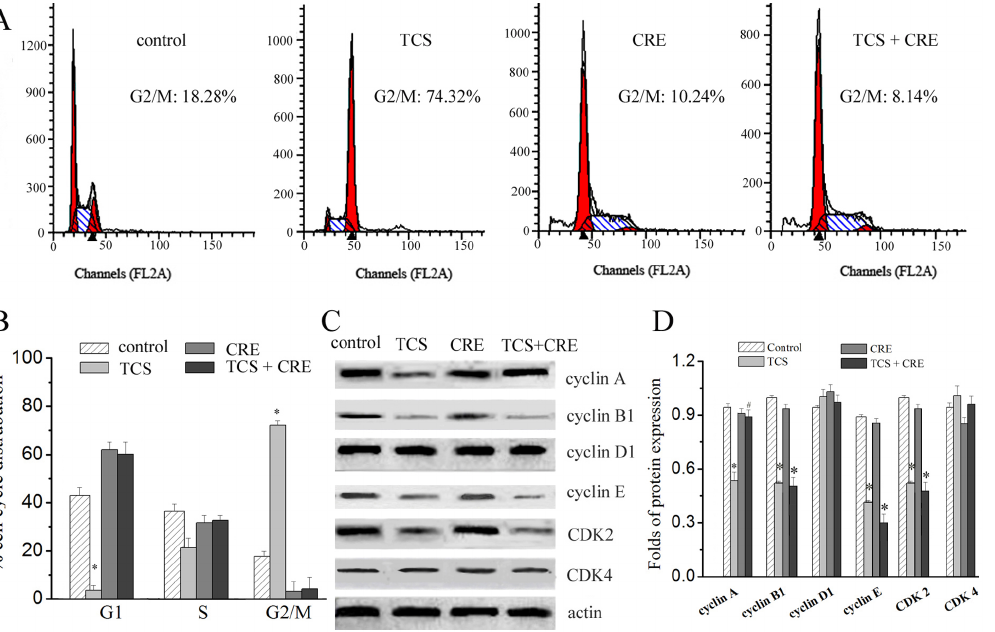
Figure 7. Effects of CRE-decoy on SW1990 cell cycle progress and regulatory proteins. TCS-induced increase of cell number in G2/M phase was significantly attenuated by the treatment of TCS + CRE (A, B). Down-regulated expression of cyclin A was reversed by the treatment of TCS + CRE. There was no effect on other proteins (C, D). Data represent means 6 SD of three independent experiments (* p , 0.05 compared with control, # p , 0.05 compared with TCS).